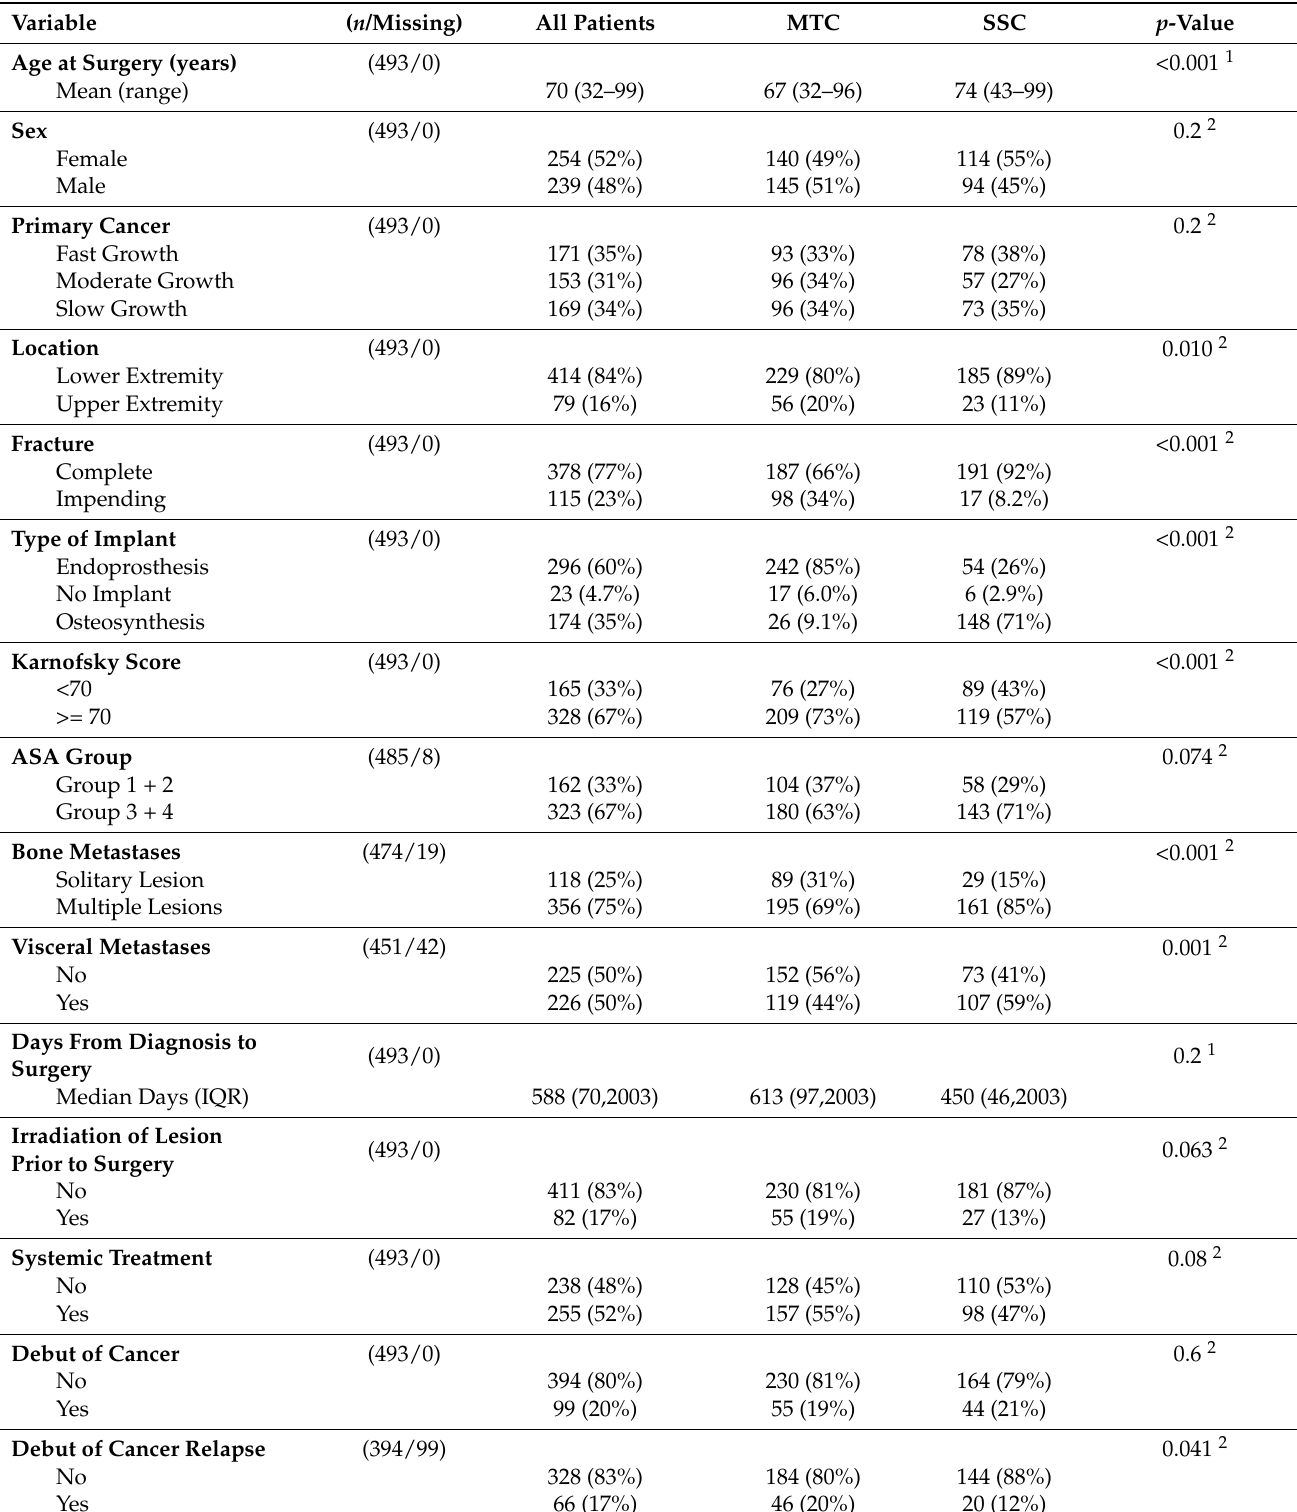
Table 1. Table describing and comparing the preoperative data of the cohort of patients treated for aBM in the CRD per